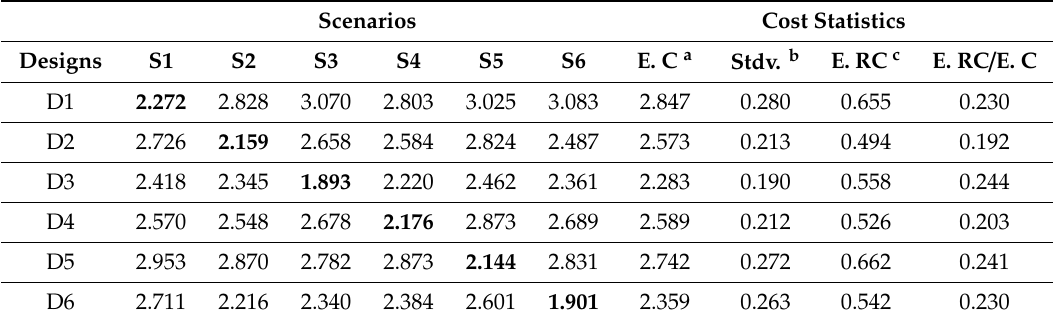
Table 3. Summary of final total costs including RC and penalty costs, and cost